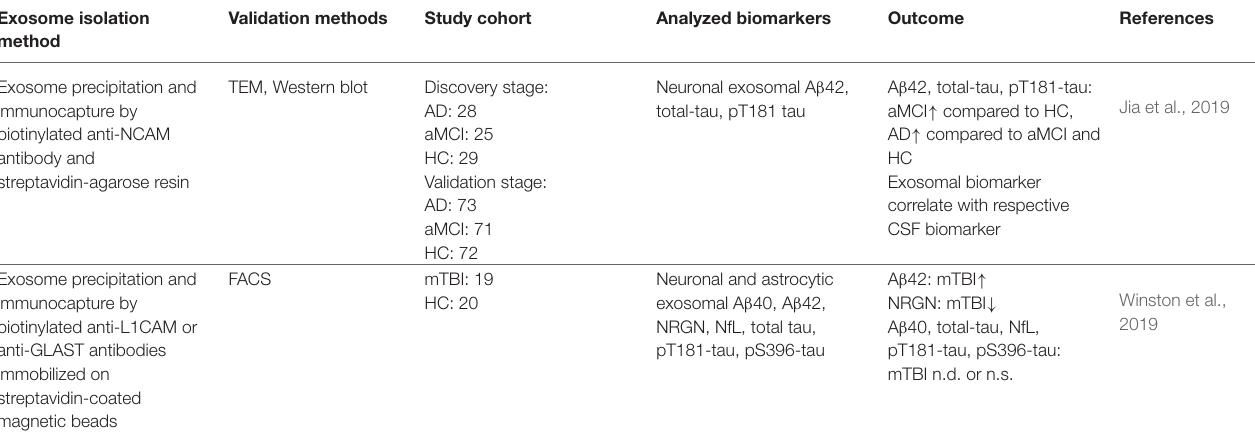
TABLE 2 | Selected publications analyzing biomarkers in CNS-derived blood